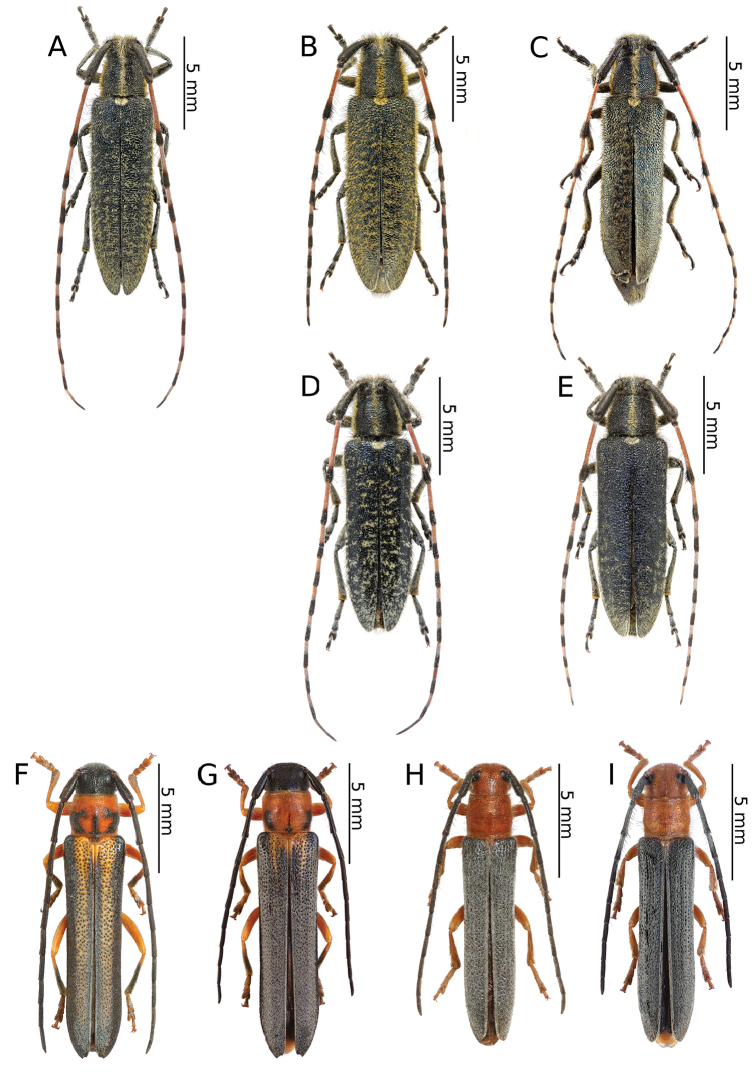
Photos of longhorn beetles specimens collected during the expedition to Kazakhstan in 2017: AAgapanthiadahlicalculensis (male) BA.dahlicalculensis (female) CA.dahli spp. (female, Karashota environs) DAgapanthiaalternansalternans (male) EA.alternansalternans (female) FObereakostini (male) GO.kostini (female) HOberearuficepsruficeps (male) IO.ruficepsruficeps (female).